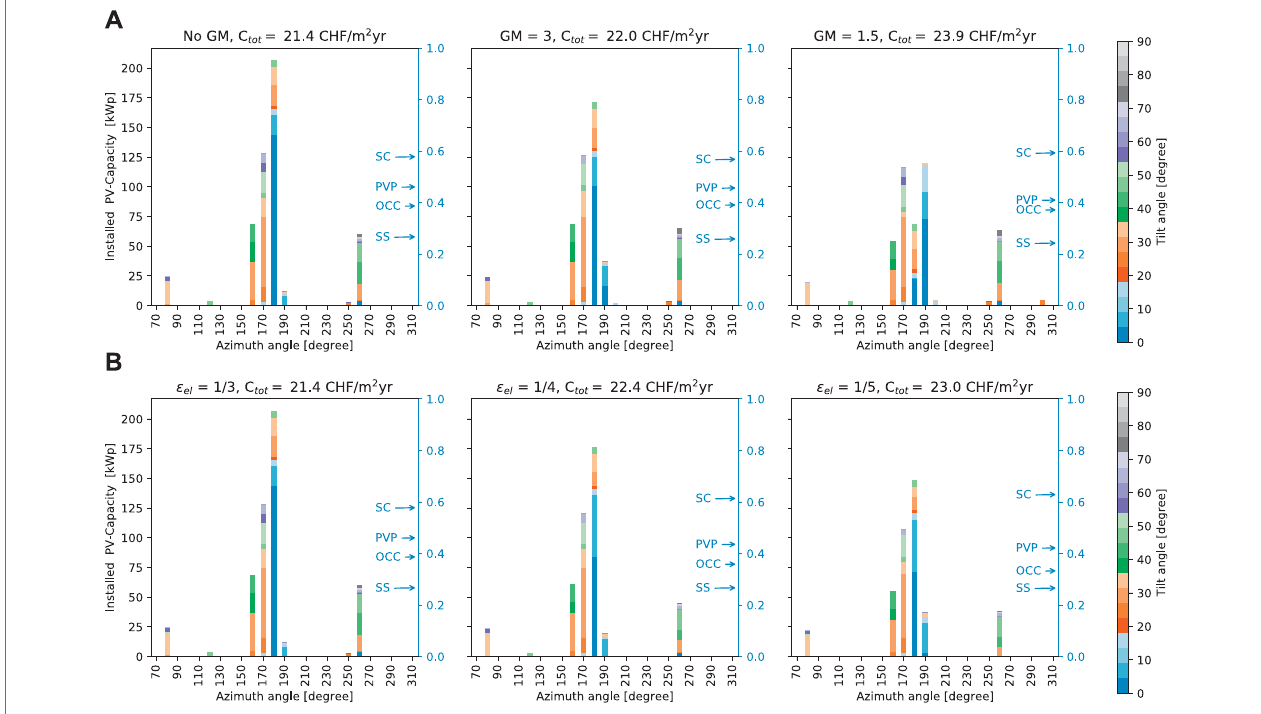
FIGURE 14 | Distribution of PV installation and orientation for total cost optimization of 40 buildings with individual load pro fi les and real roof orientations. occupancy (OCC) (A) Three different Grid constraints. (B) Three different electricity price shares ϵ el (cid:2) feed-in tariff/electricity price.